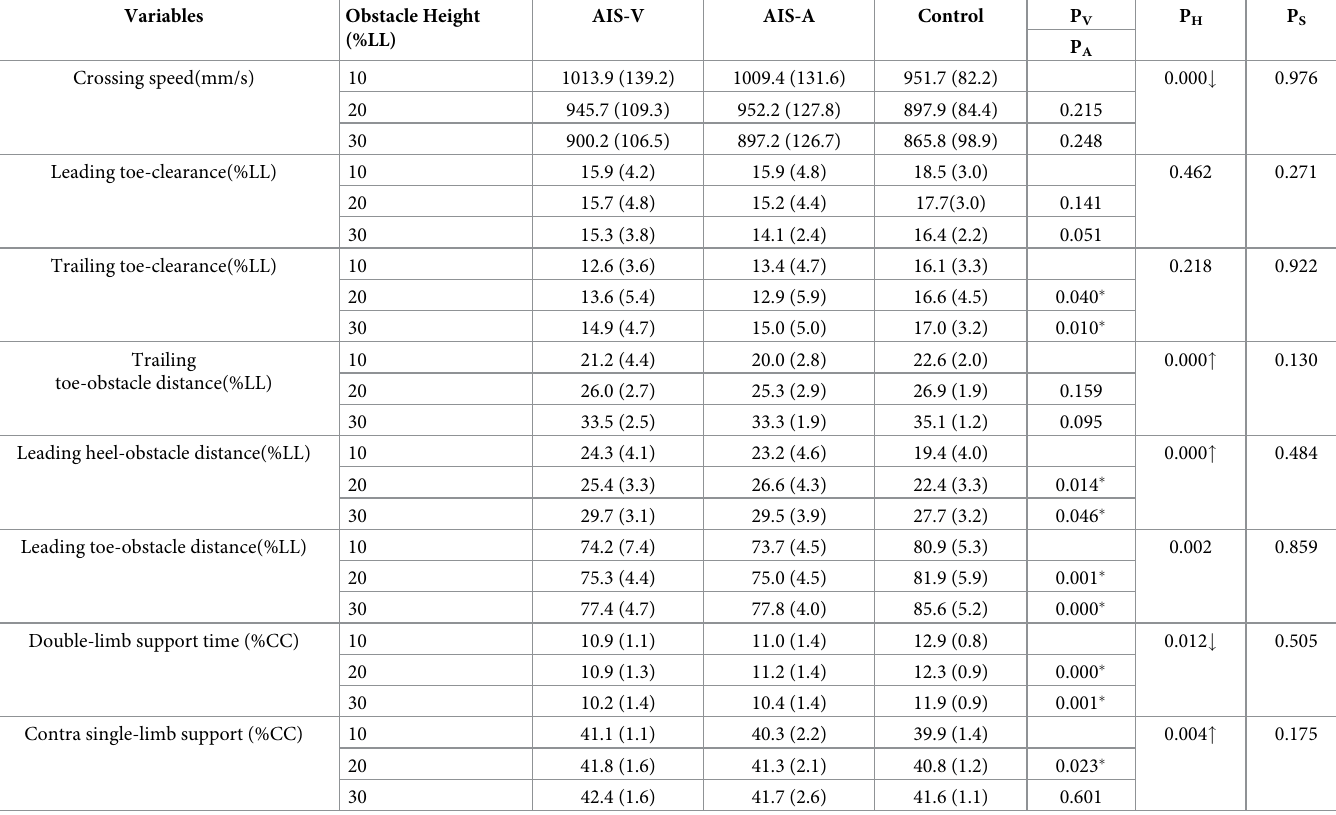
Table 1. Means (standard deviations, SD) of the end-point variables in the patients with adolescent idiopathic scoliosis and healthy controls when crossing obstacles of heights of 10%, 20% and 30% of the subjects’ leg length.